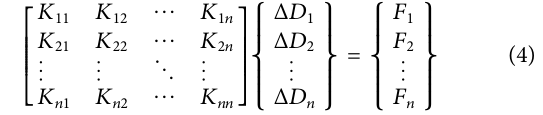
Frontiers in Earth Science |